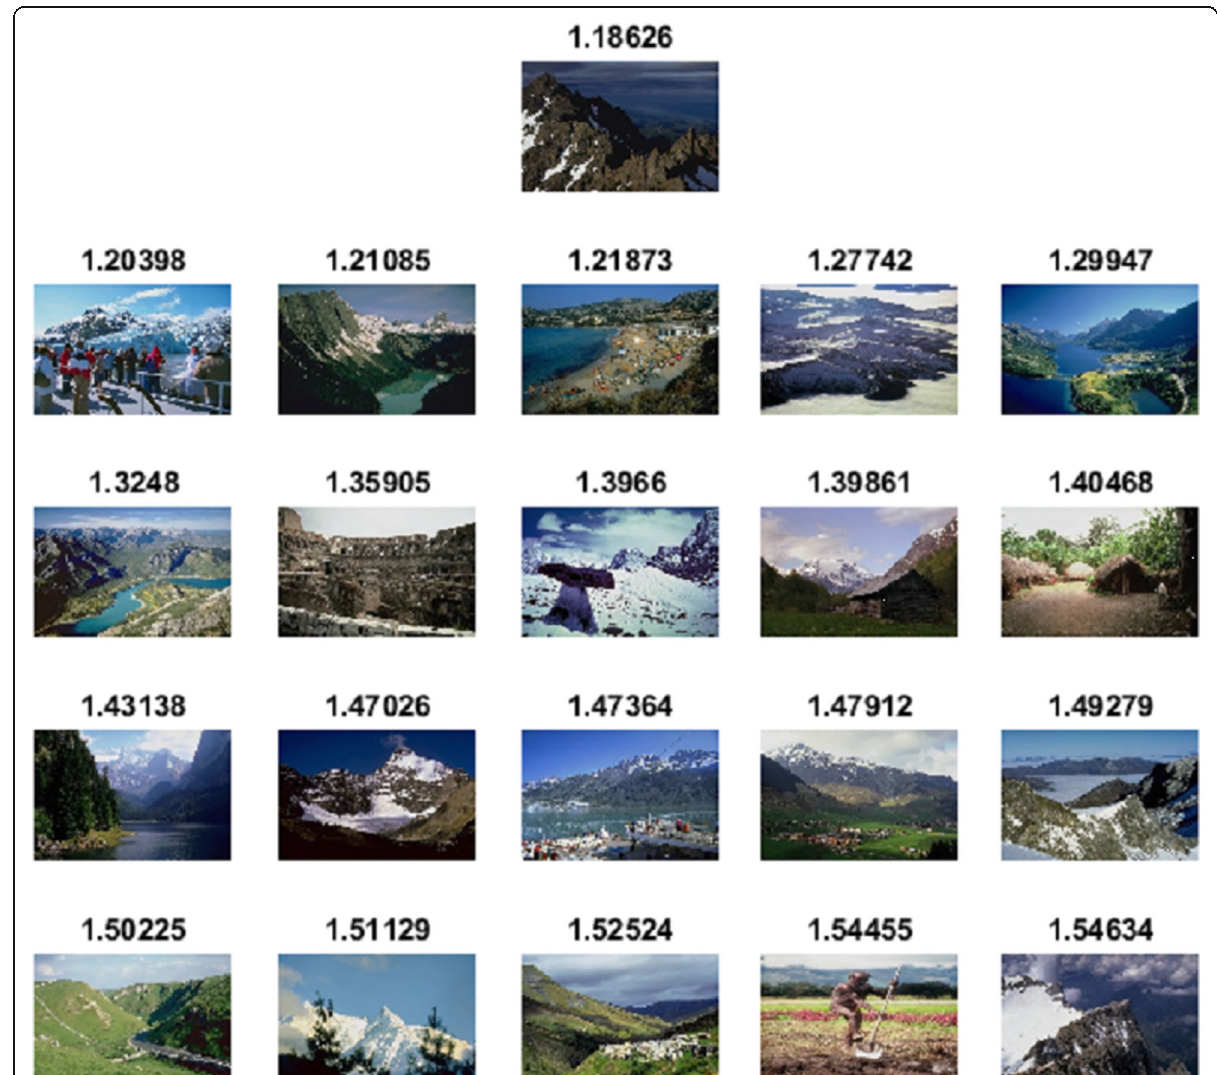
Fig. 8 Top-20 retrieved images associated with “ Mountains ” class of the image benchmark of the